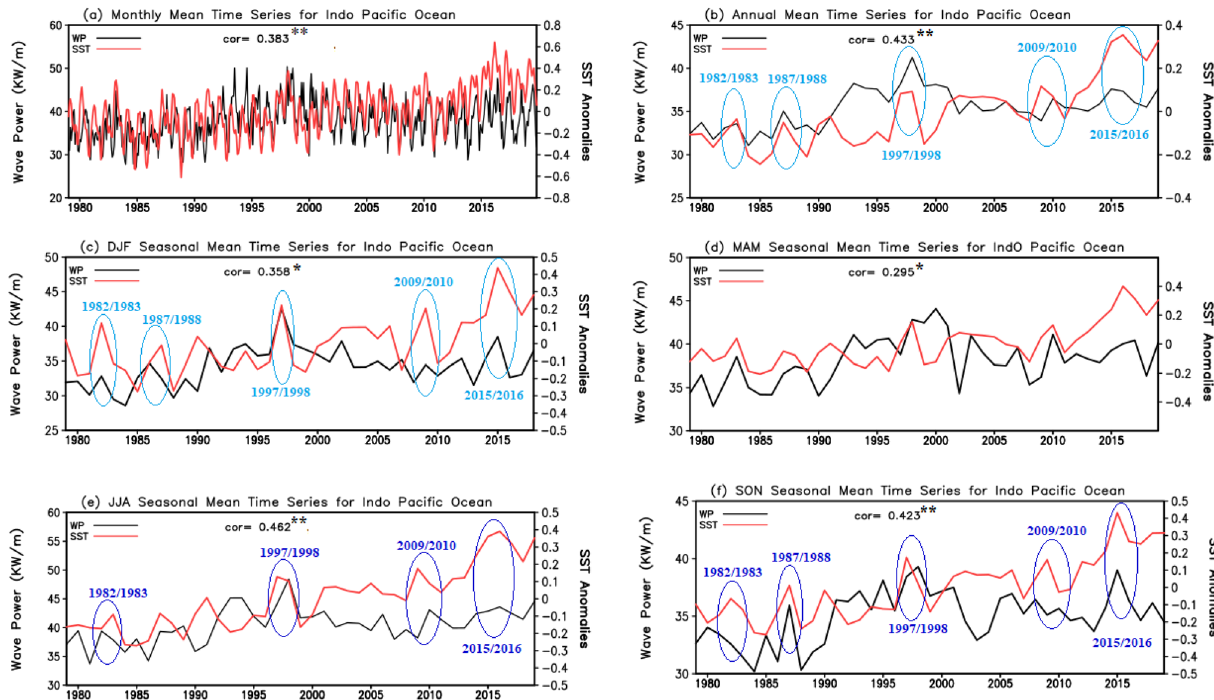
Figure 2. ( a ) Monthly, ( b ) annual, ( c ) DJF, ( d ) MAM, ( e ) JJA, and (f) SON mean time series of the WP (black, left vertical axis) and SST anomalies (red, right vertical axis) over the Indo-Pacific Ocean for the period1979–2019. Statistically significant correlations at the 99% and 95% level of confidence are indicated by ** and *, respectively, in each panel. Years with strong El Niño and/or positive IOD(pIOD) events are highlighted with blue circles, where light and dark blue, respectively, indicate El Niño only in DJF, and El Niño with pIOD in JJA and